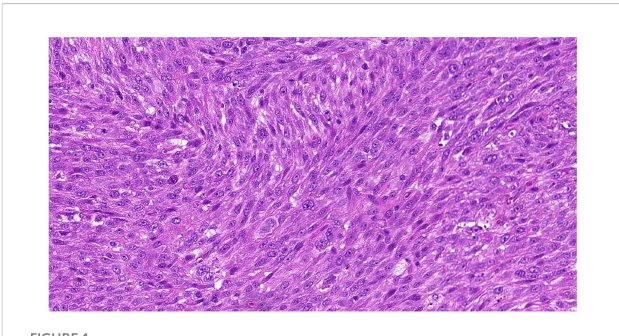
FIGURE 1 Representative Hematoxylin & Eosin Slide of Outside Referral